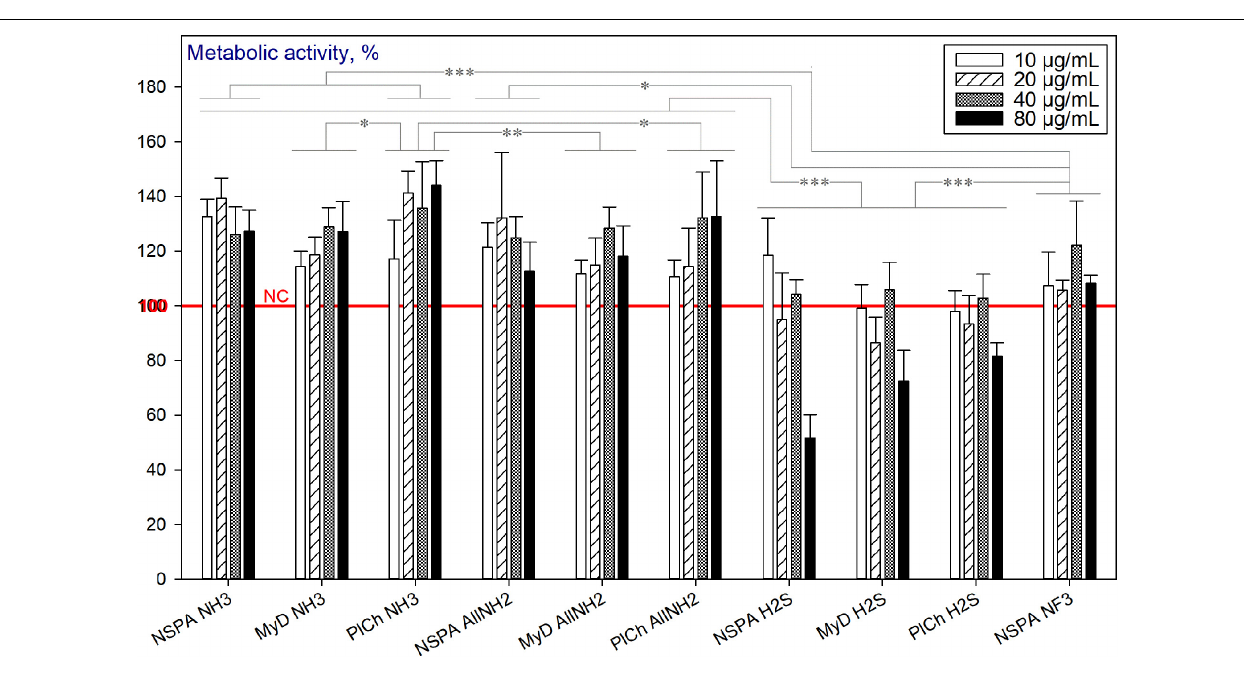
Frontiers in Bioengineering and Biotechnology |